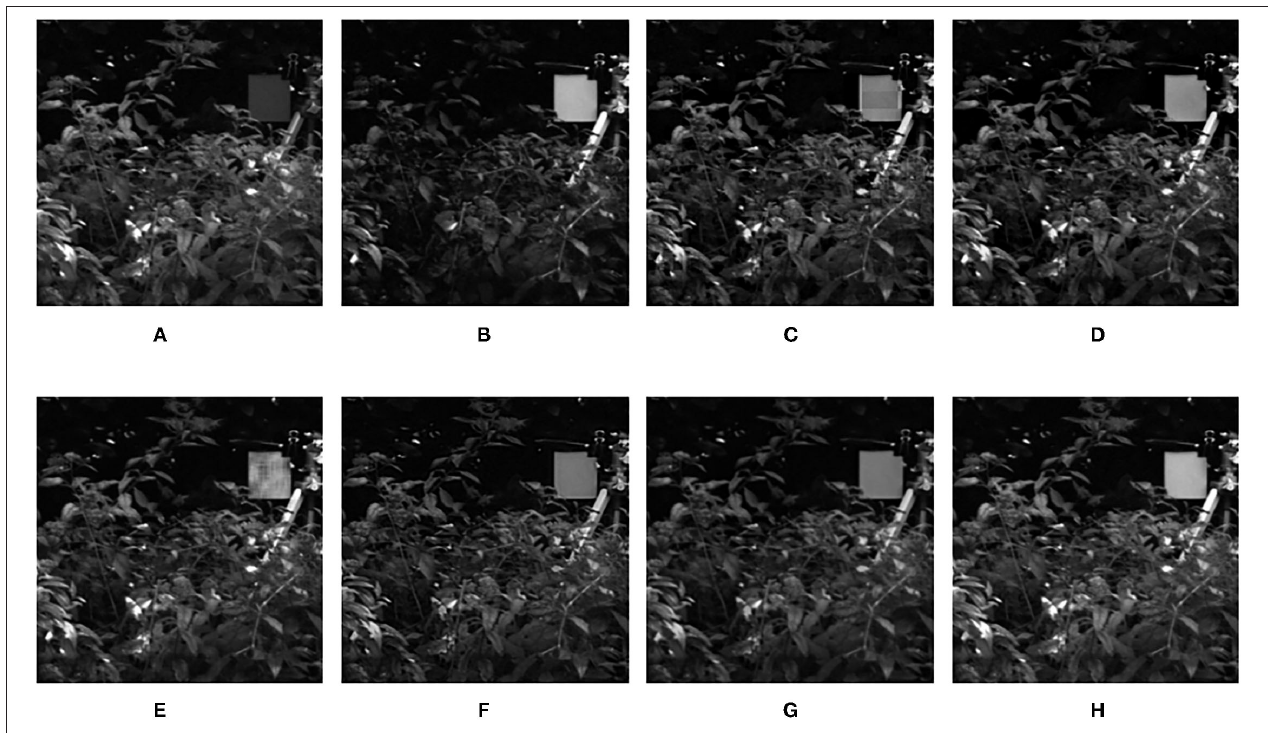
FIGURE 8 | Comparison experimental results of infrared and visible images. (A) original image (infrared image); (B) original image (visible image); (C) DWT; (D) LP; (E) SR; (F) DTCWT-SR; (G) VGG; (H) MPS.